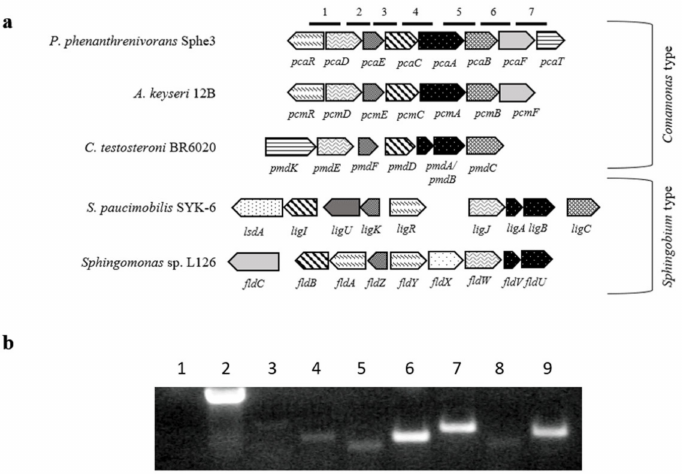
Figure 2. ( a ) Sphingobium and Comamonas types of genetic organization of gene clusters from the PCA 4,5-dioxygenation pathway in various microorganisms [16,19,20,30]. Genes: pca R (Asphe3_42340), pcm R, fld Y, putative transcriptional regulatory gene; lig R, transcriptional regulatory gene; pca D (Asphe3_42350), pcm D, pmd E, lig J, fld W, OMA hydratase; pca E (Asphe3_42360), pcm E, pmd F, lig K, fld Z, CHA aldolase; pca C (Asphe3_ 42370), pcm C, pmd D, lig I, fld B, PDC hydrolase; pca A (Asphe3_42380), pcm A, PCA 4,5-dioxygenase; pmd A, lig A, fld V, α -subunit of PCA 4,5-dioxygenase; pmd B, lig B, fld U, β -subunit of PCA 4,5-dioxygenase; pca B (Asphe_42390), pcm B, pmd C, lig C, CHMS dehydrogenase; pcm F, fld C, putative alcohol dehydrogenase; pca G (Asphe_42400), putative oxidoreductase, aryl- alcohol dehydrogenase like protein; pca T (Asphe3_42410), ABC-type molybdate transport